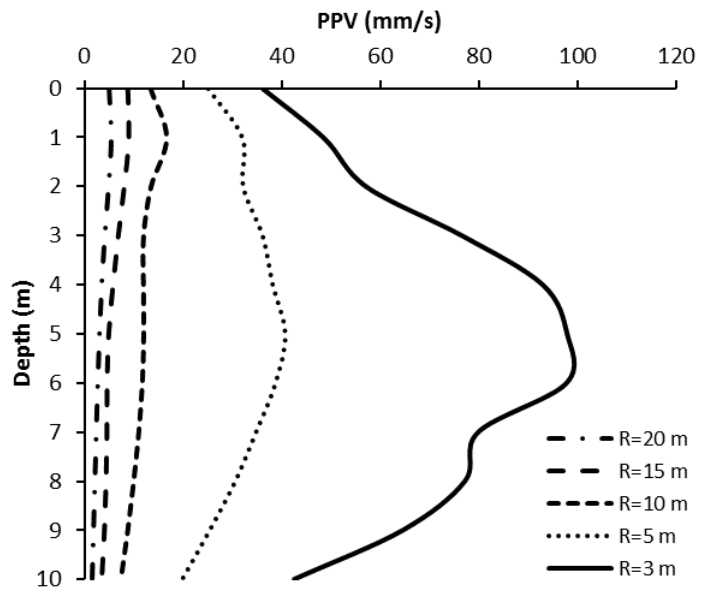
Fig. 7. PPV values computed in different depths and radial distances